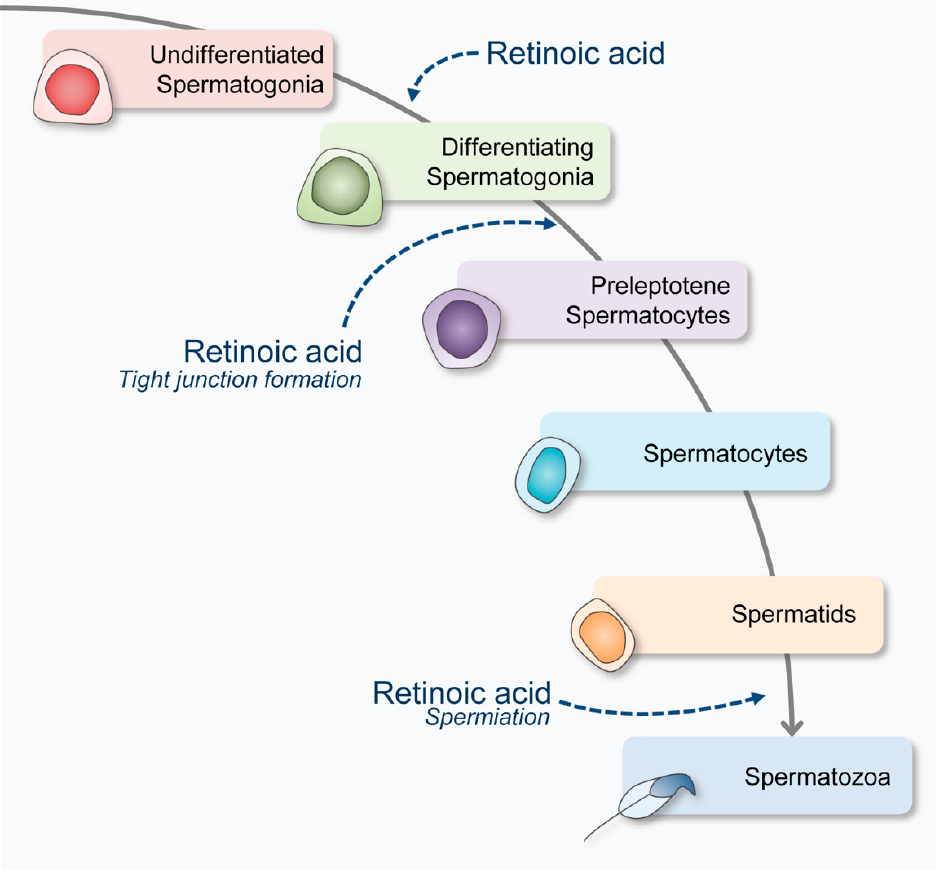
Figure 1. The role of retinoic acid (RA) throughout spermatogenesis. RA is involved in mediating differentiation and pre-meiotic activation in spermatogonia. RA is also needed for signaling within the Sertoli cell to remodel tight junctions associated with the blood–testis barrier. This crucial RA- mediated signaling allows for preleptotene spermatocyte to progress toward the lumen to await their signaled release (spermiation). Spermiation is signaled by RA within the Sertoli cells prior to releasing mature spermatids.